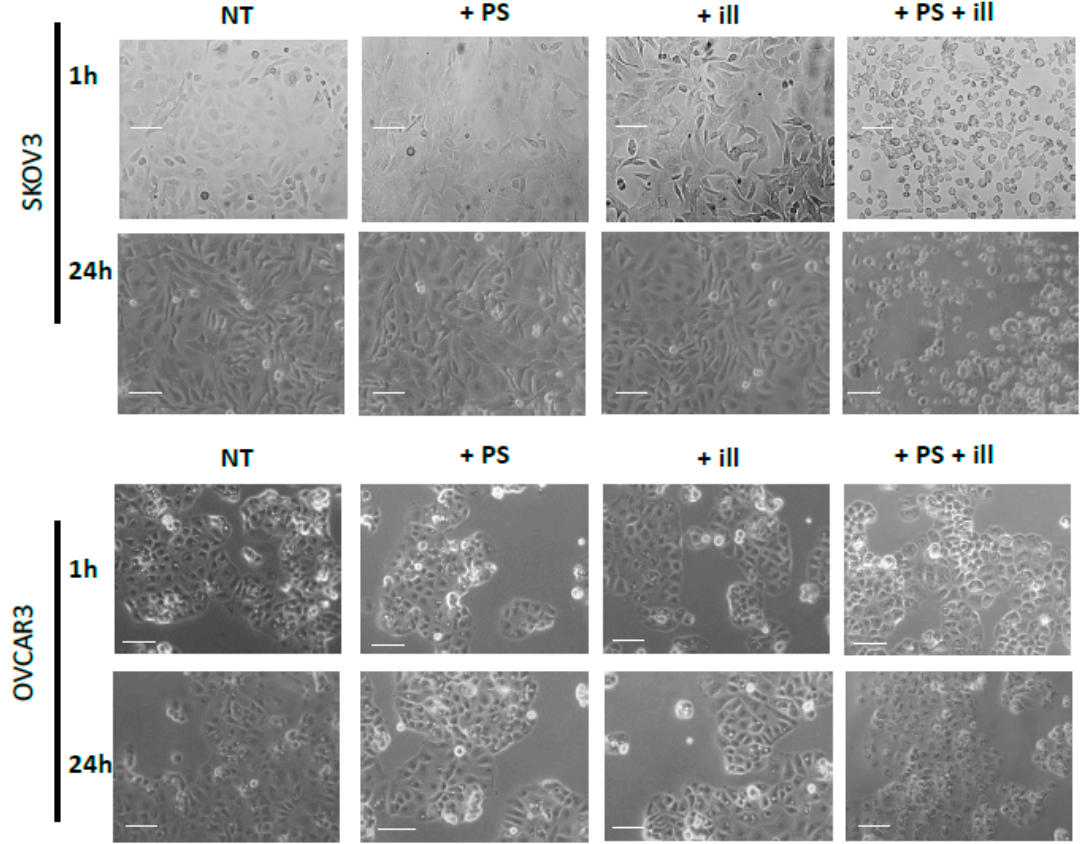
Figure 3. Phase Contrast Image-Based monitoring of OVCAR3 and SKOV3. Morphological aspects of SKOV3 and OVCAR3 tumor cells in different conditions after 1 h (upper lane) and 24 h (lower lane) post treatment. NT: non-treated, +PS: Photosensitizer only, +ill: illumination only; +PS +ill: PDT (illumination in the presence of PS). Bar = 10 μ m .